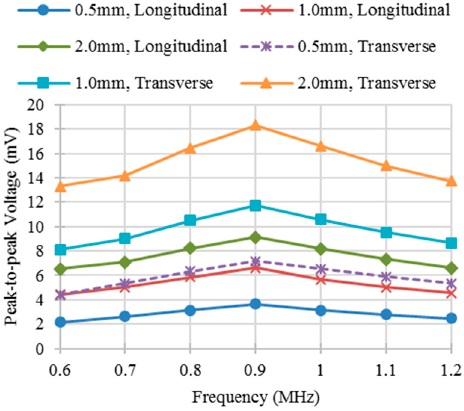
Figure 6. Peak-to-peak voltage for different kinds of defects at different frequencies from simulation. (“0.5 mm, Longitudinal” denotes longitudinal defect with 0.5 mm in depth) .